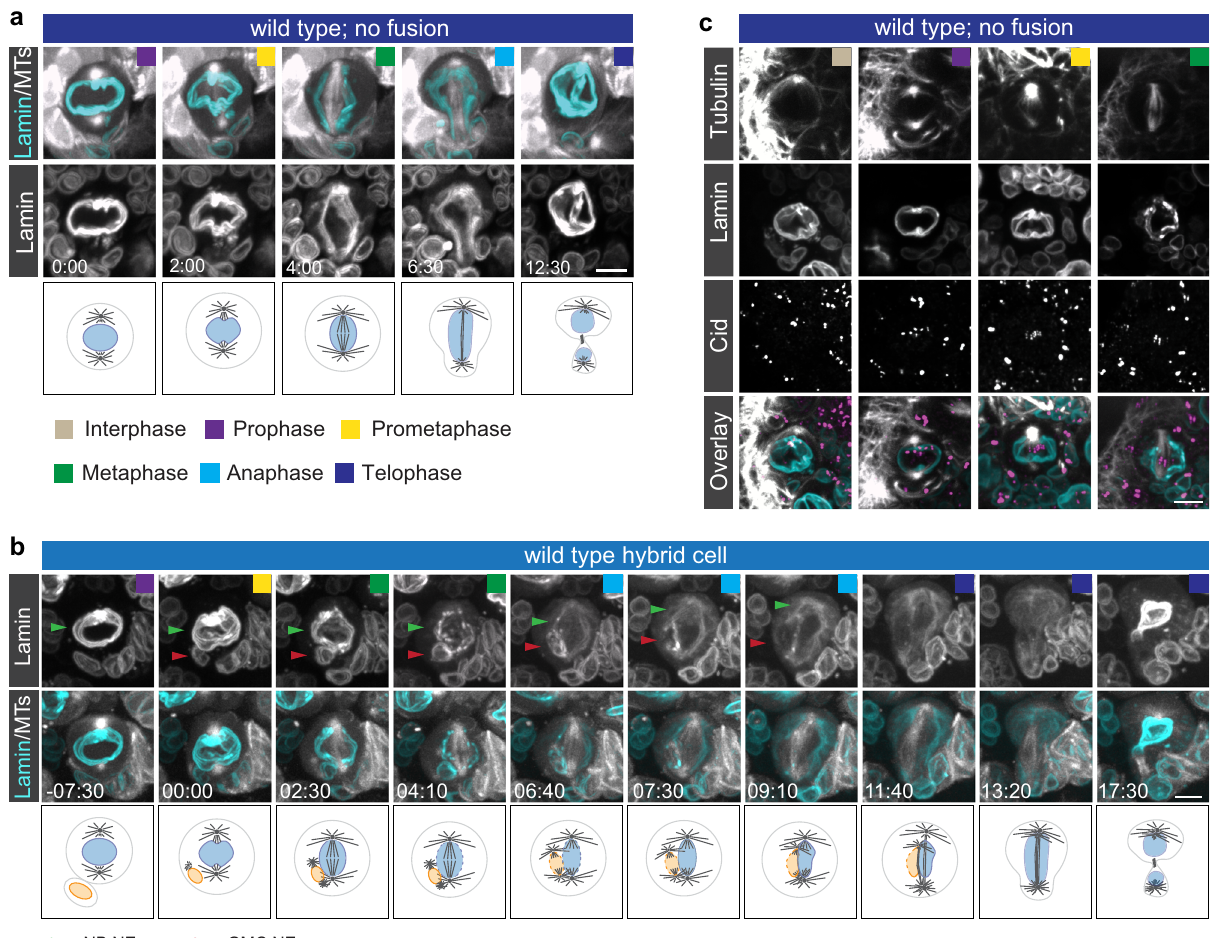
Fig. 6 Nuclear envelopes contribute to the separation of endogenous and ectopic chromatin in NB – GMC hybrid cells. a Unfused wild type neuroblasts or b hybrid cell expressing the nuclear envelope marker Lamin::GFP (cyan on top; white in the bottom row) and the spindle marker cherry::Jupiter (white on top). Schematics are shown below the image sequence. Green arrow; nuclear envelope (NE) of the neuroblast (NB). Red arrow; nuclear envelope (NE) of the ganglion mother cell (GMC). c Wild type neuroblasts expressing Lamin::GFP (cyan in merge) and stained for anti-Tubulin (white in merge) and anti-Cid (magenta in merge). Time in mins:secs. Scale bar is 5 μ synkaryons. We fi nd no evidence that heterokaryons or synkaryons are a consequence of failed cytokinesis and appear to be a result of nuclear fusion.